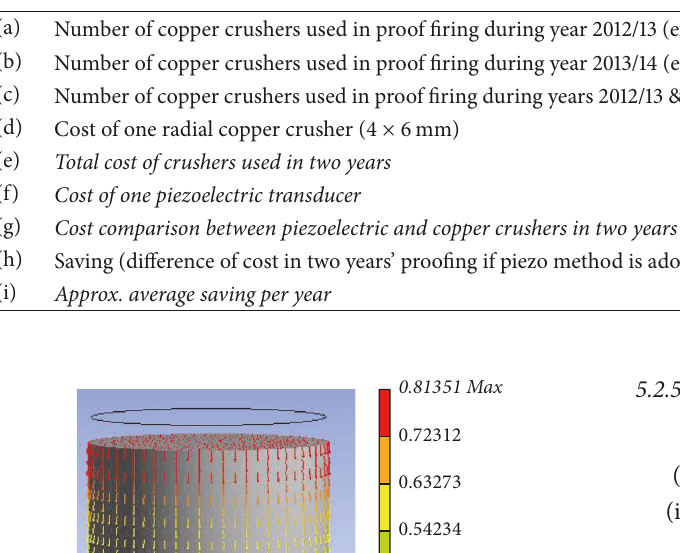
Table 7: Cost benefit analysis (CBA).